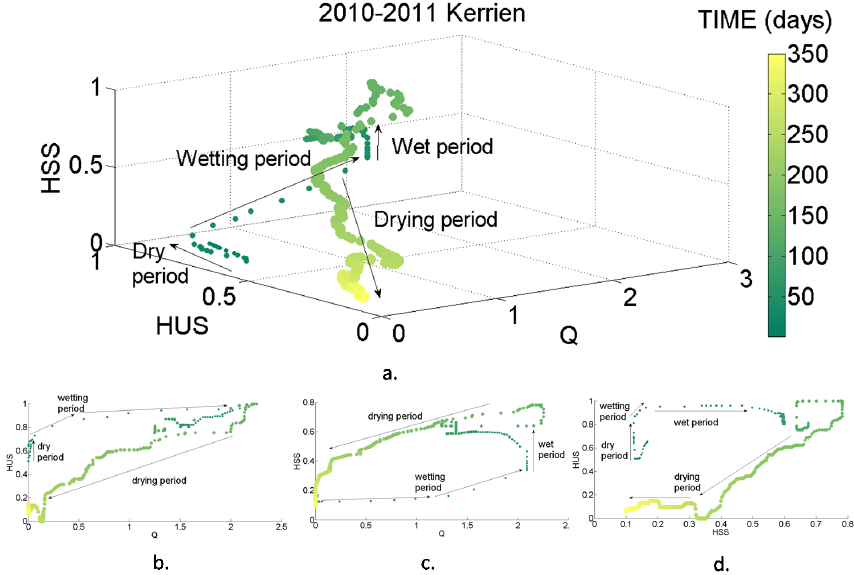
Figure 6. Evolution of stream flow ( Q in mmd − 1 ) and normalized hillslope unsaturated storage (HUS) and hillslope saturated storage (HSS) for the water year 2010–2011 (October to September). The size of the dots increases with time. Unsaturated storage (HUS) is computed from the moisture sensors in profiles sB1 and sB2; saturated storage (HSS) is represented using a normalized groundwater table level (computed from two piezometers in the hillslope). (a) is the 3-dimensional plot and (b, c, d) are the respective 2-dimensional projections of (a) on the three